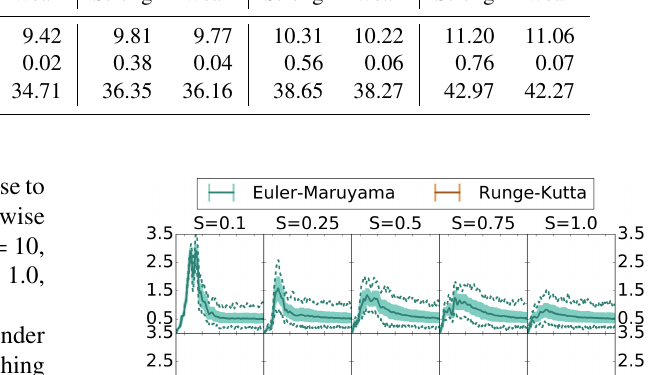
Table 1. Estimated discretization error constant C . The constant corresponds to the expected bound of the discretization error, C(cid:49) γ , where (cid:49) is the maximum time step of the discretization and is sufficiently small. γ equals 1 . 0 for Euler–Maruyama and Runge–Kutta and 2 . 0 for (cid:16) (cid:17) Taylor. Values of C are rounded to O 10 − 2 . Diffusion s = 0 . 1 s = 0 . 25 Scheme/mode